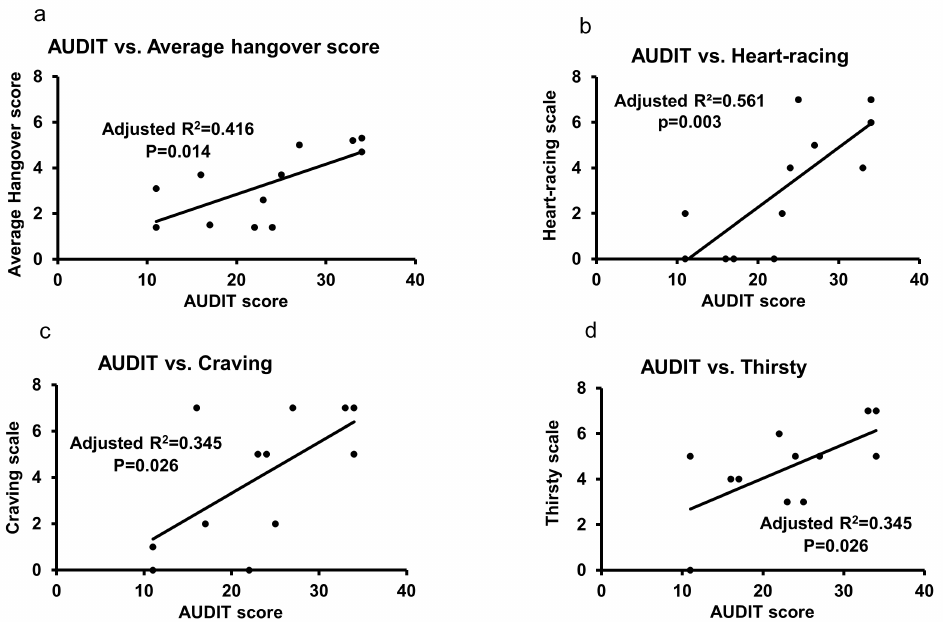
Figure 3. Association of AUDIT and hangover measures in heavy drinkers. ( a ) AUDIT and “Average hangover score” (AvgAHS). ( b ) AUDIT and “Heart-racing” (sympathetic domain) measure. ( c ) AUDIT and “Craving” (mental domain) measure. ( d ) AUDIT and “Thirsty” (physical domain) measure. Statistical significance was set at p ≤